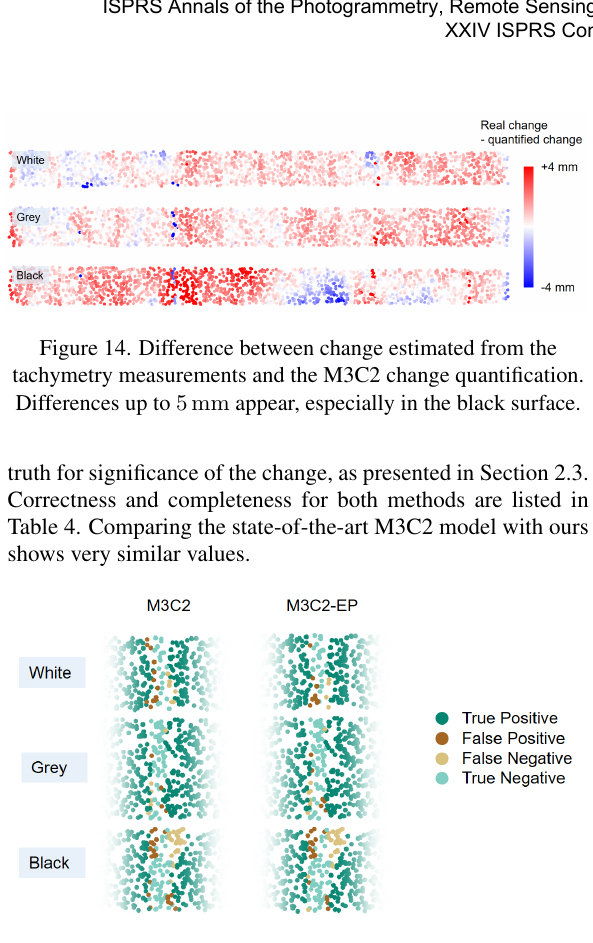
Figure 15. Significant changes for the change detection at 60m range and between 0 ◦ and 10 ◦ incidence angle, cropped to the center part of the board. Points beyond the faded boundaries are all ”True Positive” (TP) change. The points are coloured according to their confusion matrix, i.e. whether the indicated significance matches the one from the reference.